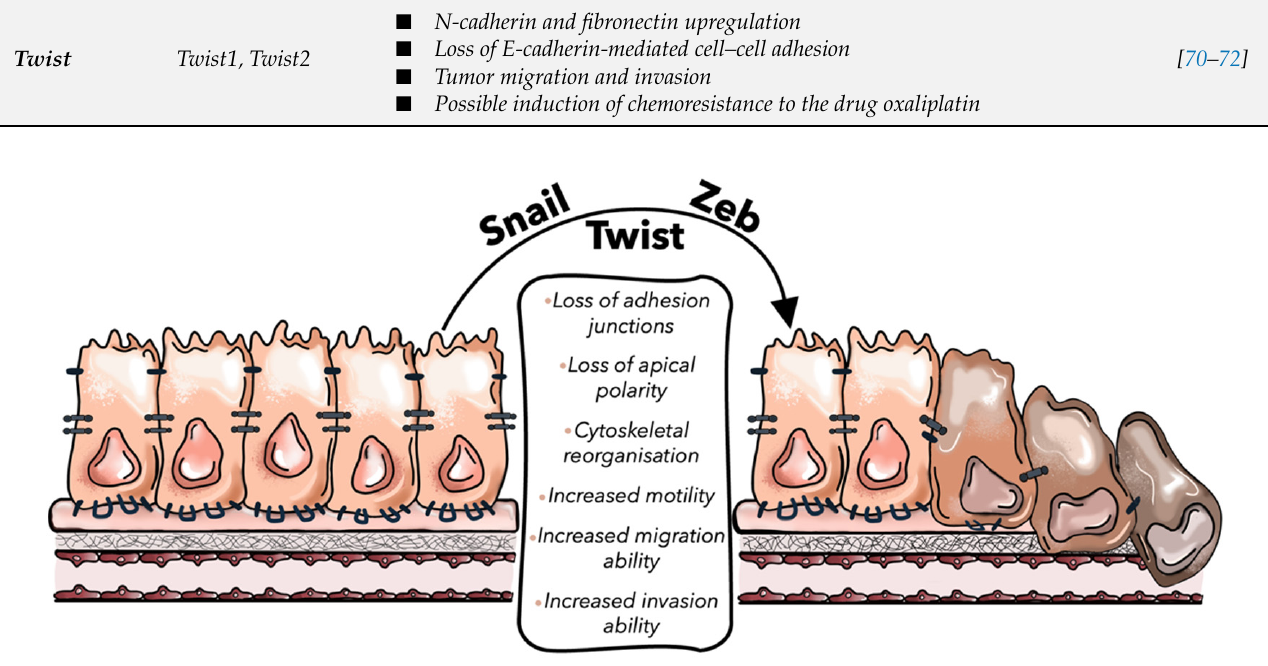
Figure 2. Representative image of the EMT process. Snail, Twist, and Zeb, EMT-promoting transcription factors (EMT-TFs), promote the loss of cellular epithelial characteristics, such as the disassemble of cell–cell junction, the defect of apical–basal polarity and cytoskeletal reorganization, supporting the acquisition of a mesenchymal phenotype of tumor cells.